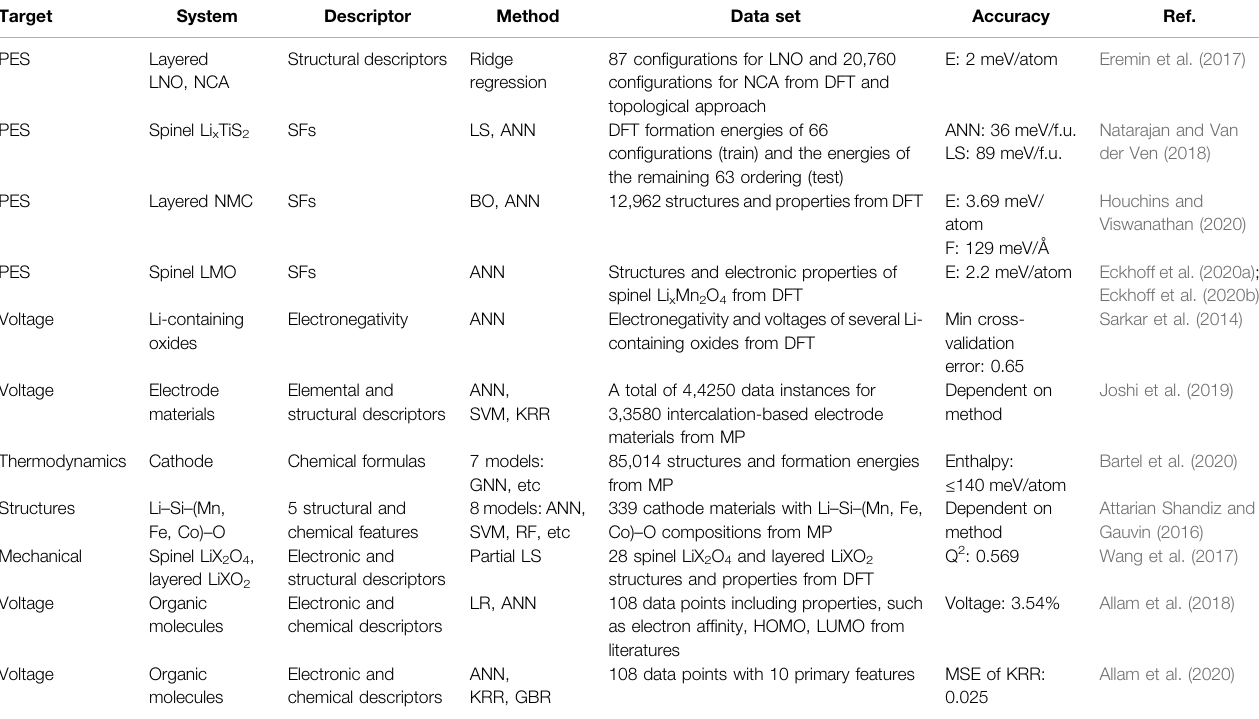
TABLE 1 | Summary of ML applications in cathode